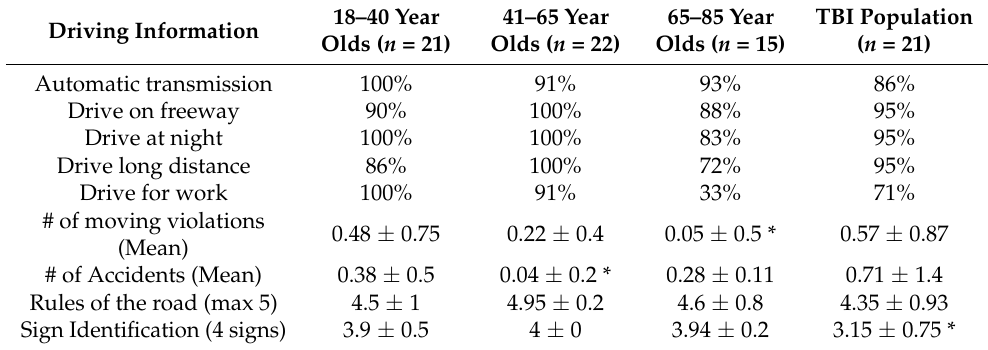
Table 2. Intake Driving information.